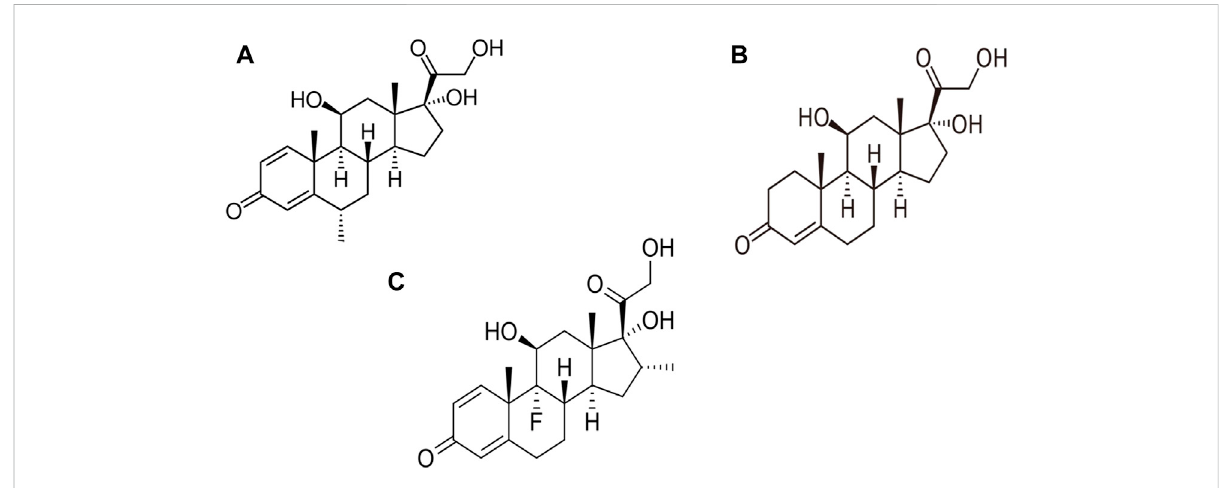
FIGURE 3 Structure of steroids used in the management of COVID-19. (A) Methylprednisolone, (B) Hydrocortisone, (C) Dexamethasone.